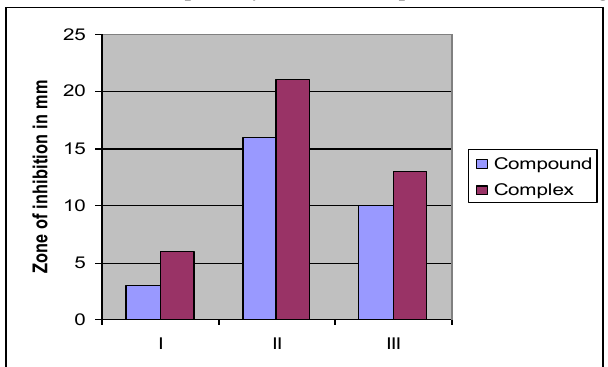
Figure 4A: Antimicrobial susceptibility test of Compound I, II and III against S.aureus.